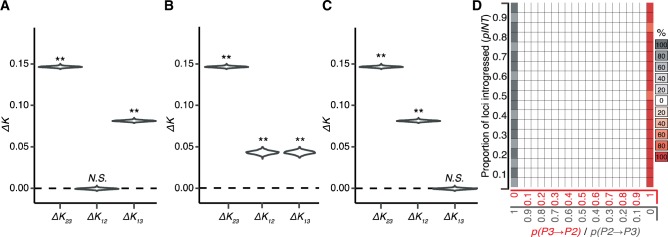
—DIP analysis of simulated introgression. Genomes were simulated according to steps 1–3 in supplementary figure S1, Supplementary Material online, under unidirectional P2⇒P3 introgression (A), symmetrical bidirectional P3⇔P2 introgression (B), and unidirectional P3⇒P2 introgression (C). Simulation parameters are as follows: (A), n = 5,000, pINT = 0.5, p(P3⇒P2) = 0; (B), n = 5,000, pINT = 0.5, p(P3⇒P2) = 0.5; (C), n = 5,000, pINT = 0.5, p(P3⇒P2) = 1. DIP was applied to each genome to yield profiles of ΔK23, ΔK12, ΔK13. ** indicates significant departure from 0 (P < 0.01). (D) A plot scanning simulation parameters, proportion of the genome that was introgressed (pINT) (y axes) and proportion of introgressed loci transferred in each direction (p(P3⇒P2)) (x axis). Each square in the plot indicates the DIP results obtained from five replicated simulated genome alignments. Red boxes indicate the profile consistent with P3⇒P2 introgression (see panel C). Gray boxes indicate the profile consistent with P2⇒P3 introgression (see panel A). The shading of the boxes corresponds the percentage of replicates that indicate a given profile, as specified by the key to the right of the plot. Unshaded boxes indicate zero replicates yielded a significant unidirectional profile (i.e., all replicates yield the bidirectional introgression profile; see panel B).